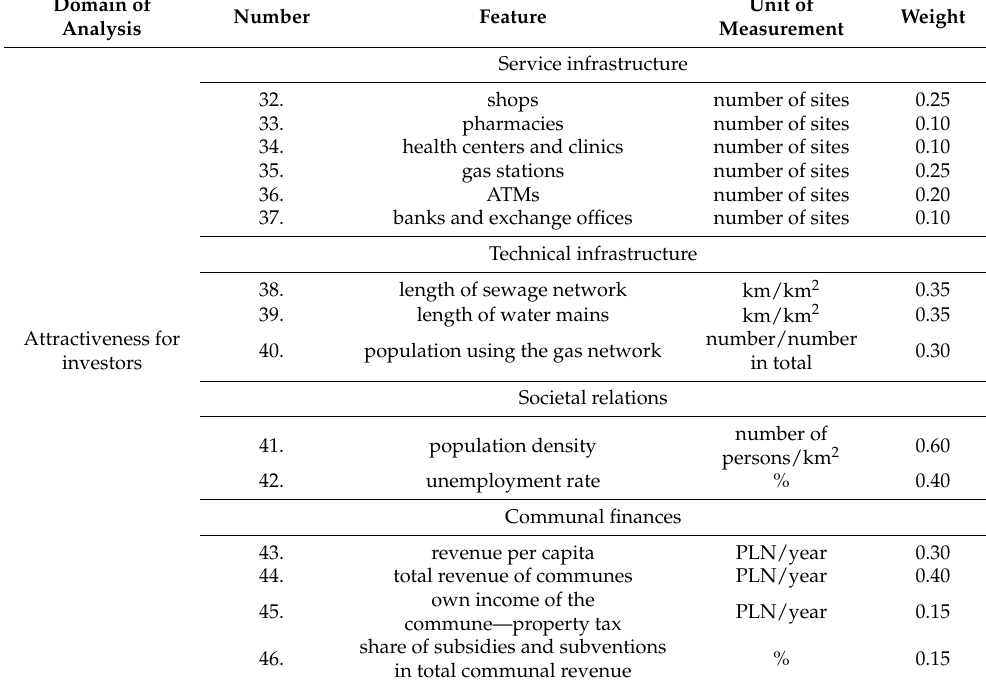
Table 3. Diagnostic features in the domain of attractiveness for investors and their